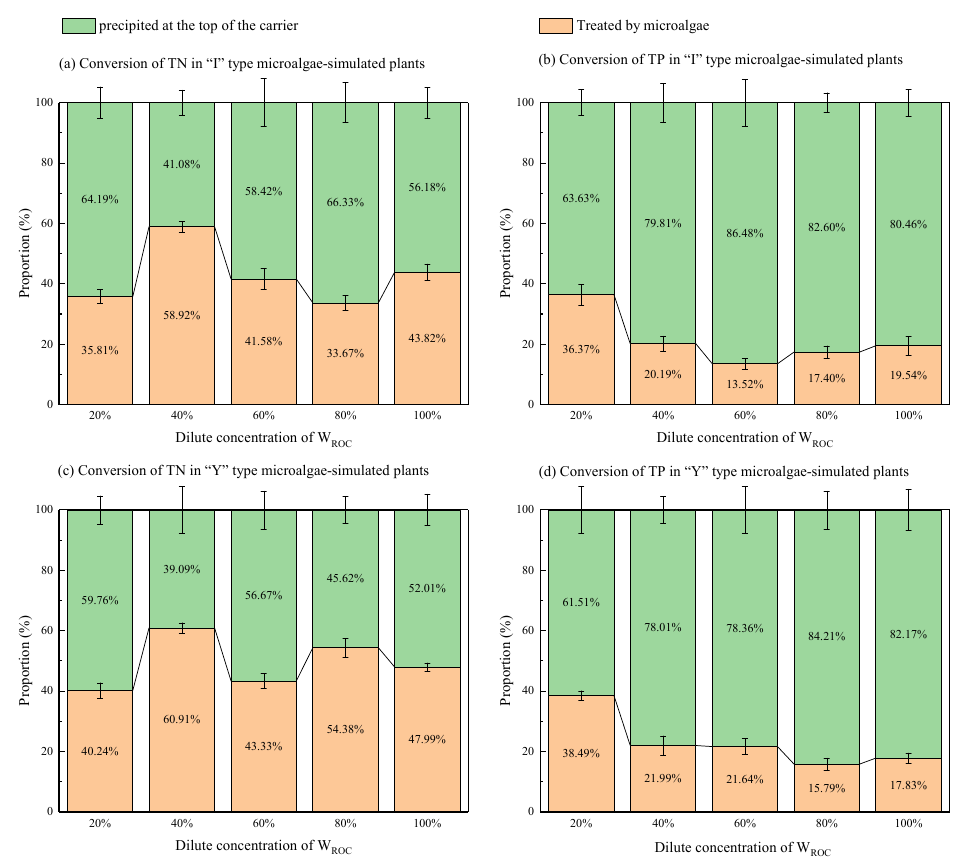
Figure 6. Conversion of nutrients in the attached microalgae-simulated plant system. ( a ) Conversion of TN in “I” type plant; ( b ) conversion of TP in “I” type plant; ( c ) conversion of TN in “Y” type plant; ( d ) conversion of TP in “Y” type plant.